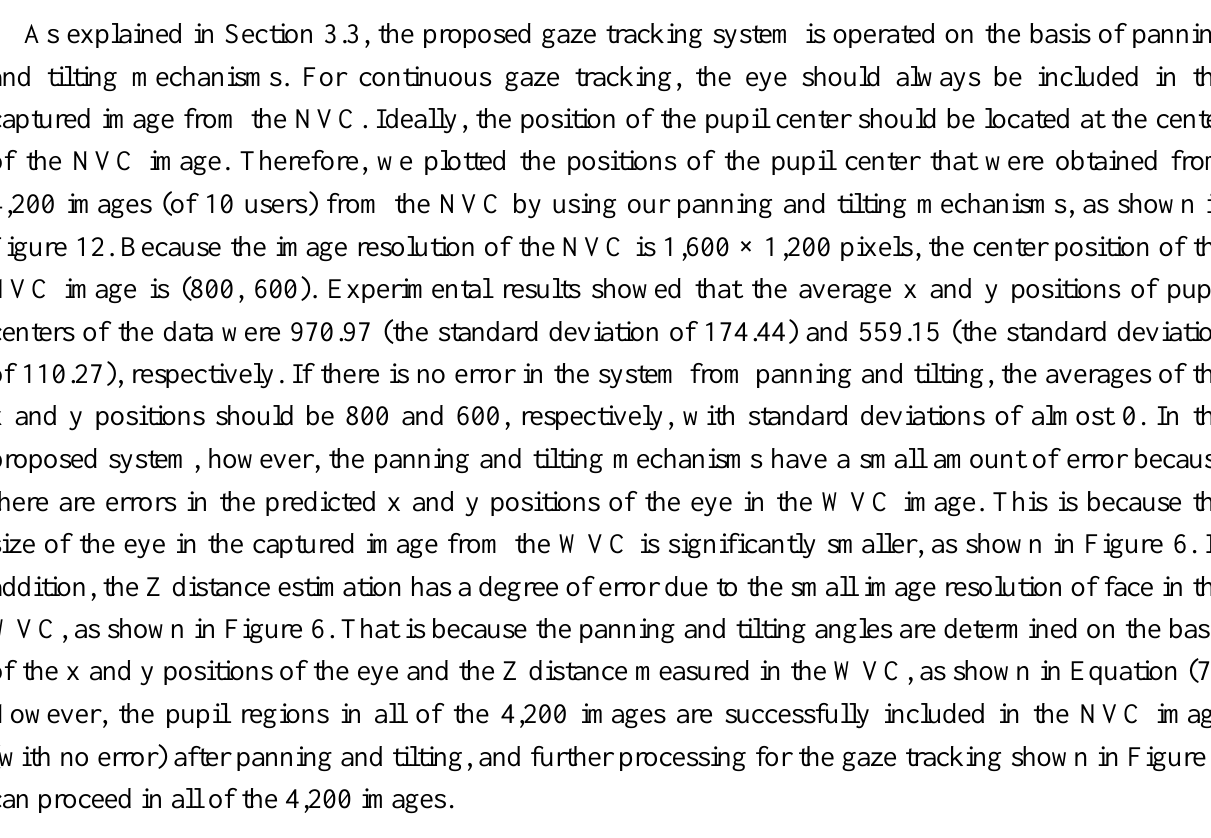
Figure 12. Positions of pupil centers of 4,200 NVC images after panning and